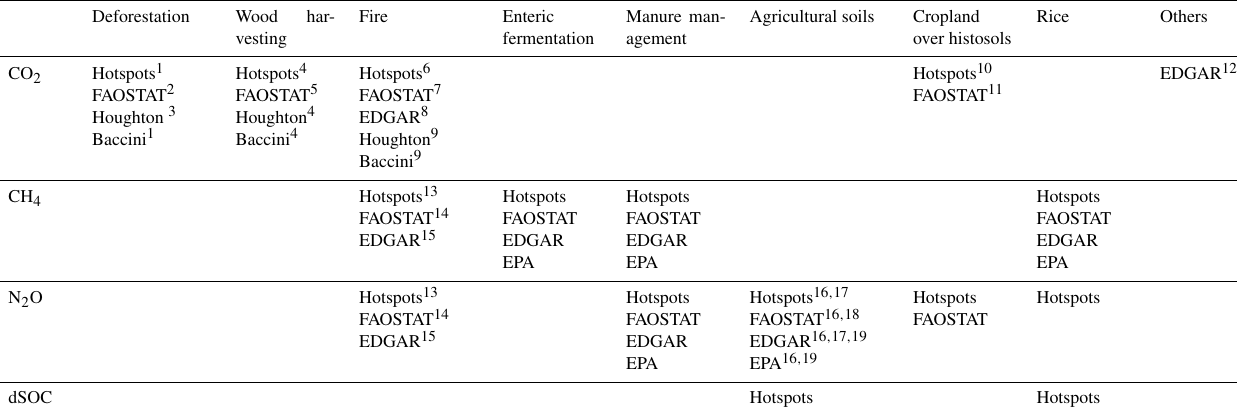
Table 3. Characteristics of the emission sources used in this comparative assessment disaggregated by greenhouse gases for the period 2000– 2005, for the Hotspots, FAOSTAT, EDGAR, EPA, Houghton, and Baccini datasets (based on gross emissions from Baccini et al., 2012). Superindices specify differences between datasets and/or indicate the exact data included in our database comparisons. EPA offers only non- CO 2 emissions for agriculture. Houghton offers only CO 2 FOLU emissions. Baccini gross emissions include deforestation, fire, and wood harvesting only. dSOC refers to changes in soil organic carbon. Wood harvesting and fire are considered as forest